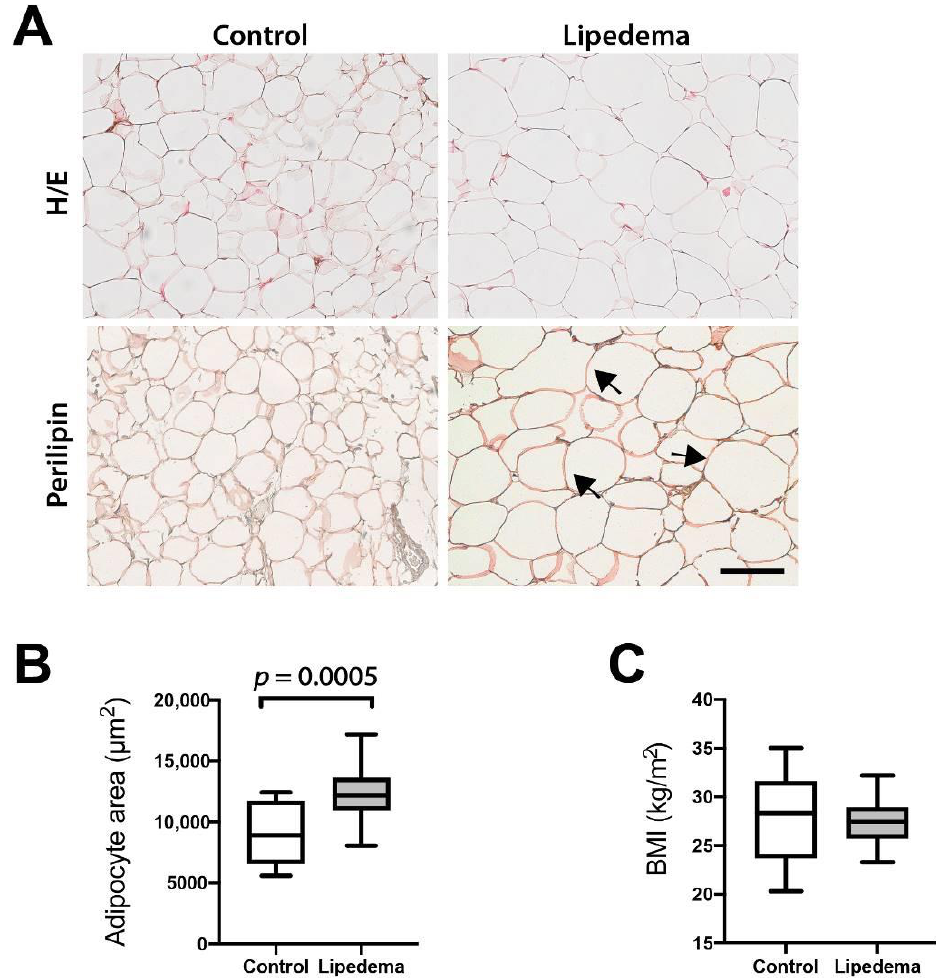
Figure 1. Adipocyte hypertrophy in lipedema. ( A ) Hematoxylin/eosin (H/E) and Perilipin immunostaining of paraffin- embedded adipose tissue demonstrating that even the largest adipocytes remain perilipin positive. The arrows indicate the large perilipin-positive adipocytes. Scale bar: 100 µ m. ( B ) Quantification of the adipocyte size using the hematoxylin/eosin sections reveals adipose tissue hypertrophy. ( C ) The body mass index (BMI) values of the control and lipedema patients appear comparable. N (Control): 10 patients and N (Lipedema): 20 patients. The p- values indicate the statistical significance in comparison to the control (two-tailed Student t-test).